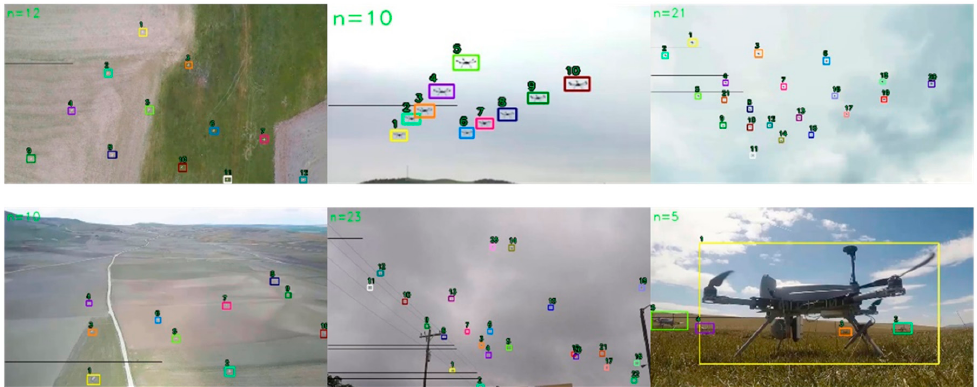
Figure 3. Sample annotated images of the UAVSwarm dataset.